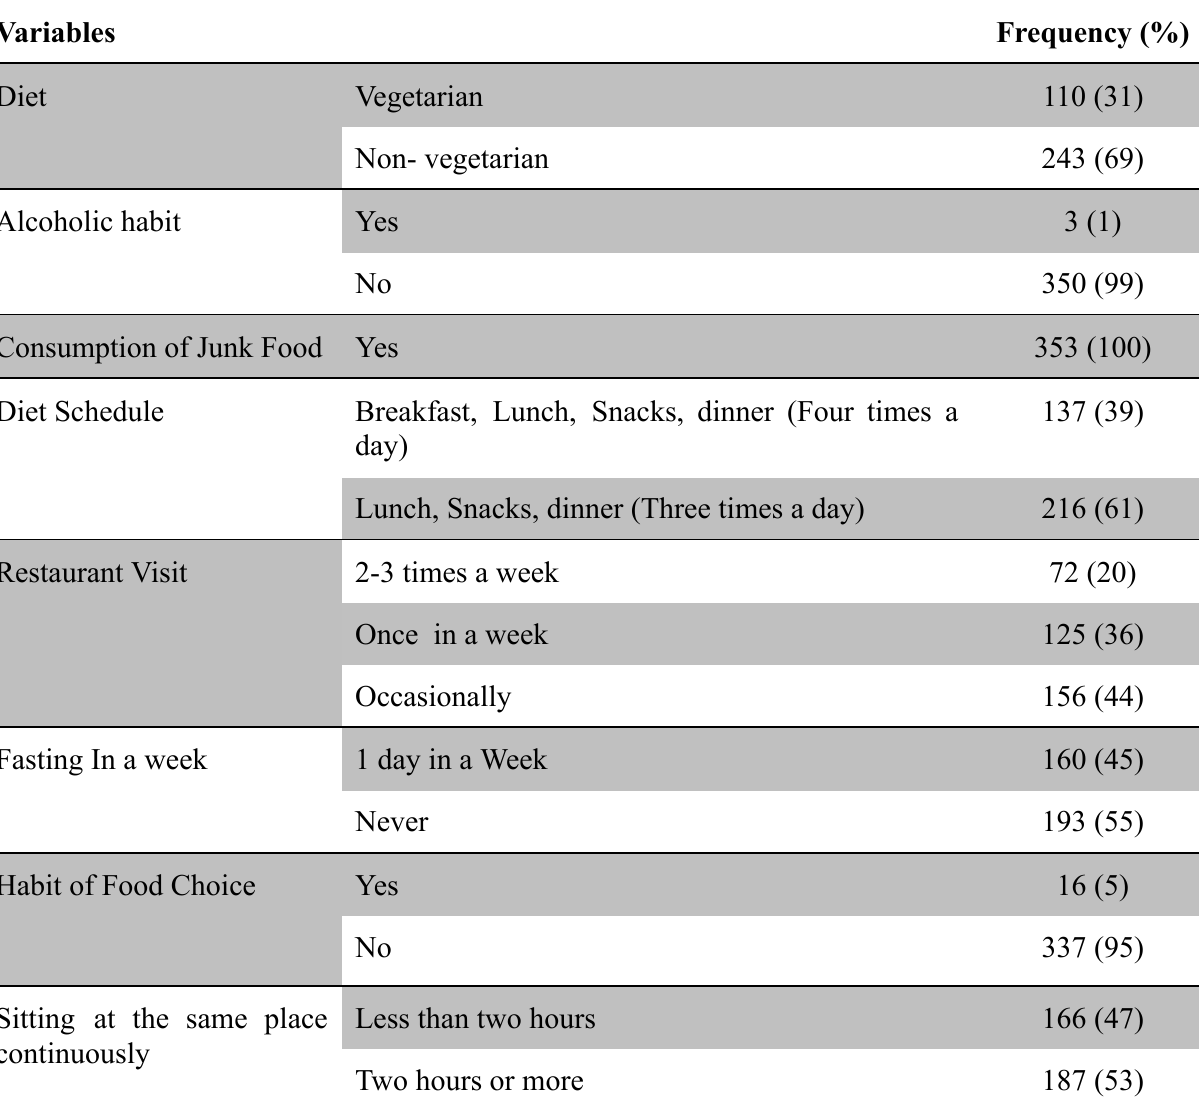
Table 3. Lifestyle profile of the respondents (N= 353)